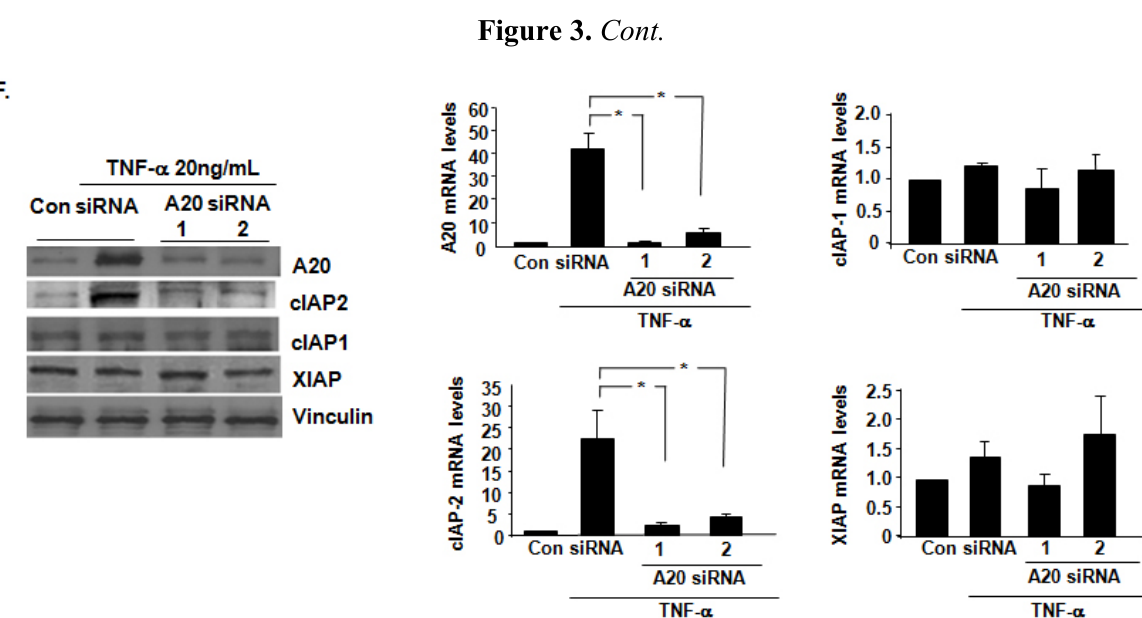
Figure 4. The PI3-K signaling pathway is involved in A20-mediated TNF- α -induced cIAP-2 expression. ( A ) Quantitative-PCR analysis of cIAP-2 mRNA levels in